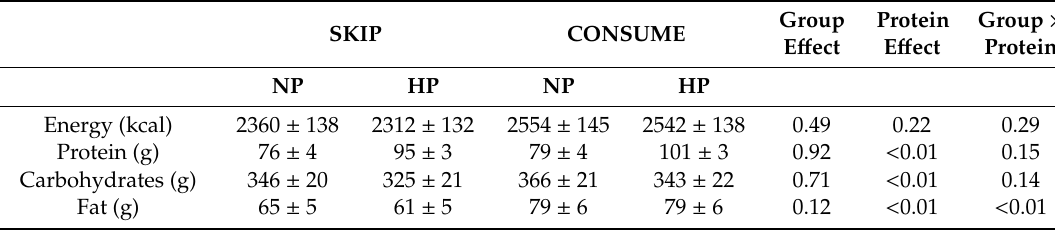
Table 2. Daily energy content and macronutrient intake following the consumption of a normal-protein breakfast (NP) and a higher-protein breakfast (HP) in habitual breakfast skippers (SKIP) and consumers (CONSUME). Data are reported as means ± SD.